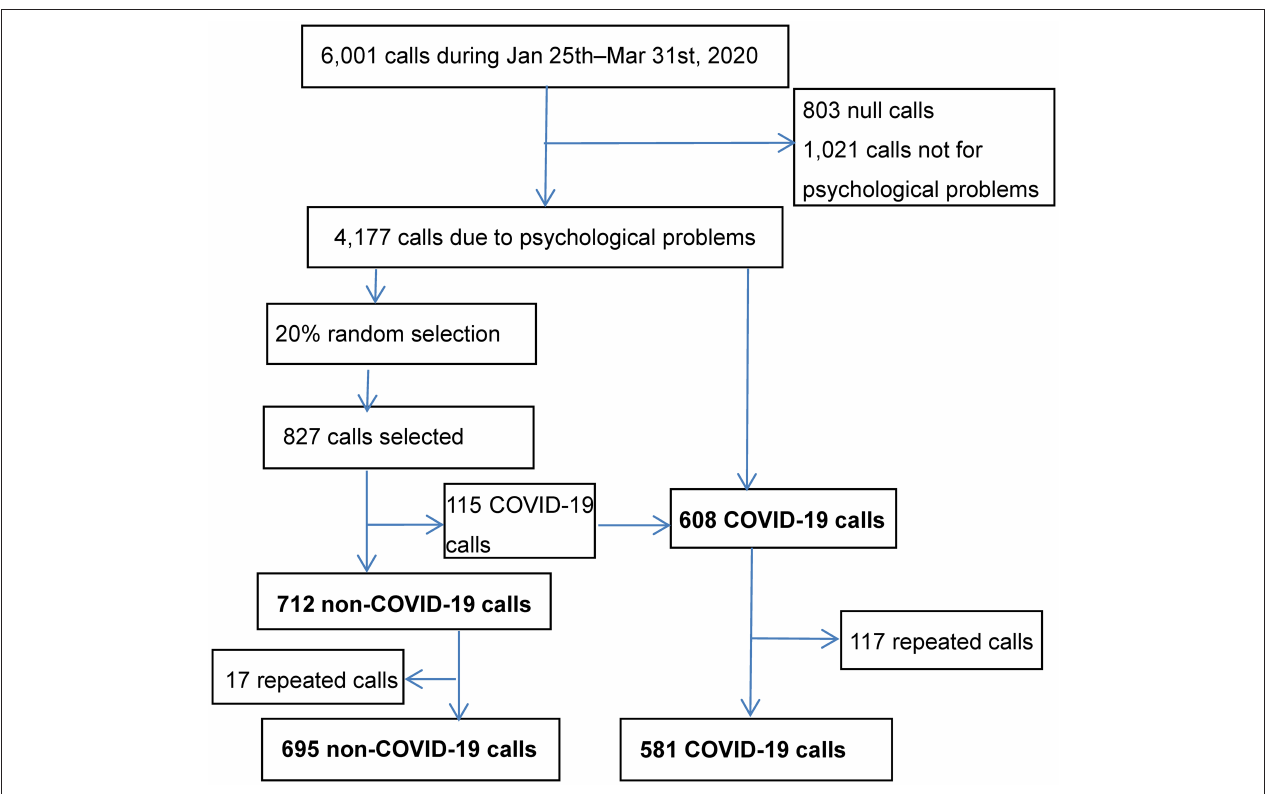
FIGURE 1 | Flow chart for recruitment of the